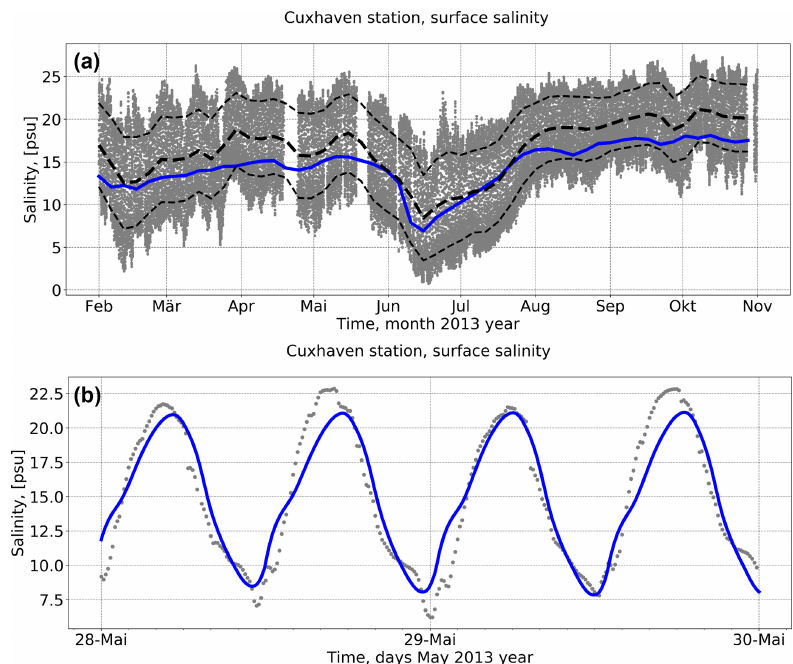
Figure 12. Modeled (blue line) and observed (gray dots and dashed black lines) sea surface salinity (SSS) at the Cuxhaven station. The station is positioned at the mouth of the Elbe River between stations 9 and 13 in Fig. 11. Panel (a) shows 9 months of simulations, and panel (b) shows results from two selected days in May. The blue (modeled with the Miura advection scheme) and thick dashed black (observation) lines in (a) show running-mean SSS with a time window of 10 periods for the M 2 tidal wave. Thin dashed black lines are 1 standard deviation bounds of the running-mean observed SSS in (a) .